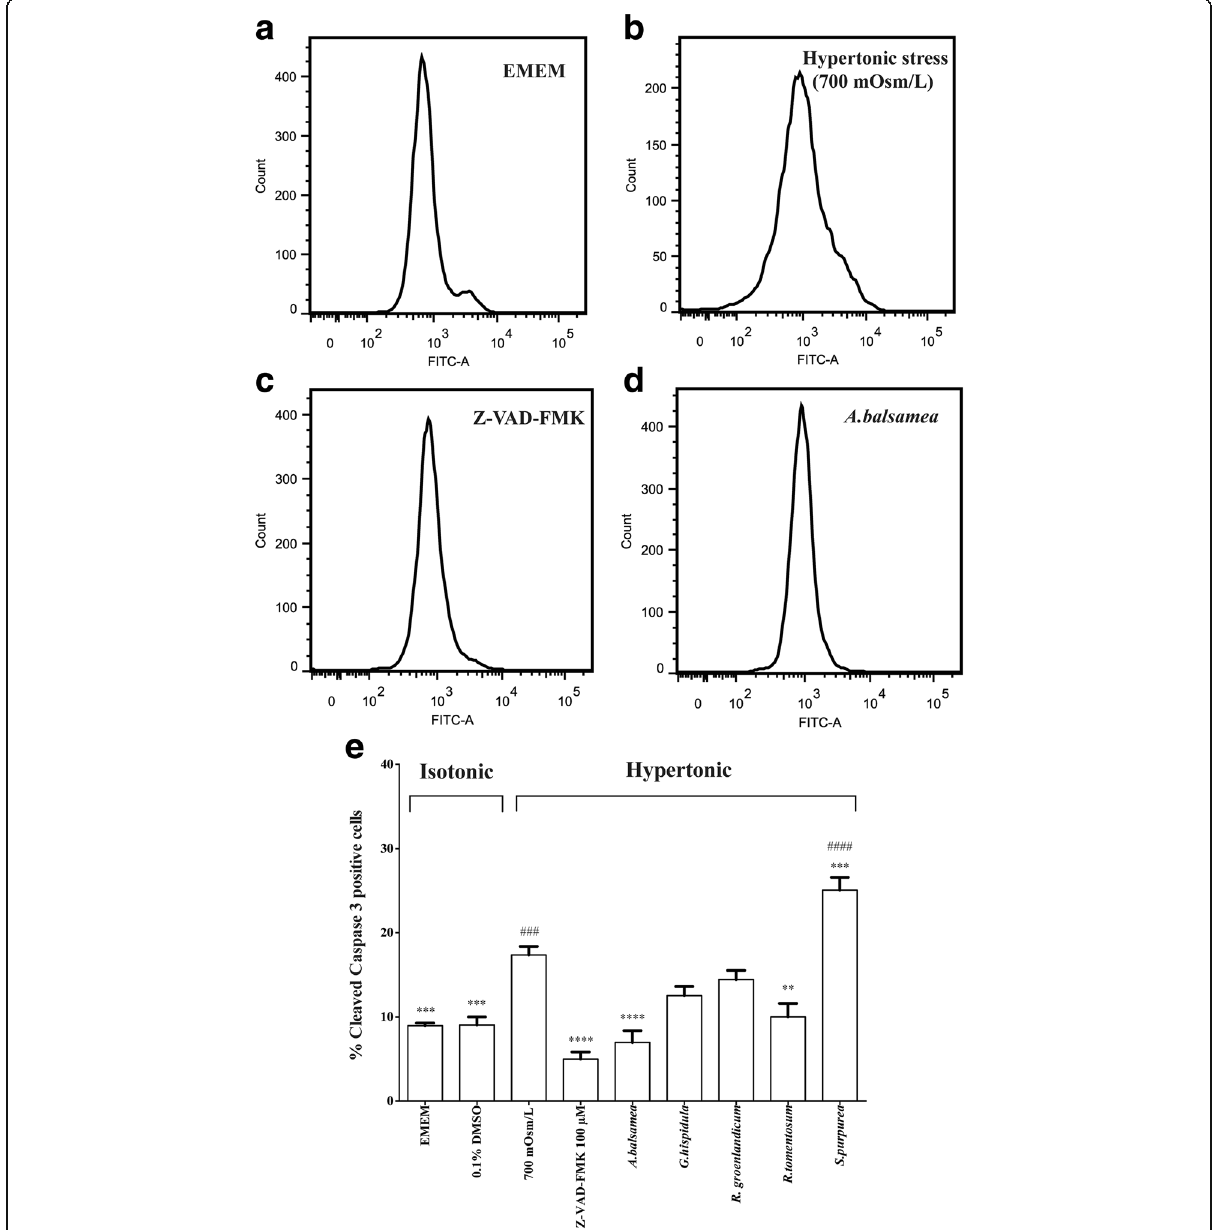
Fig. 2 Cleaved caspase 3 activity. Cleaved caspase 3 activity test was performed 18 h after the treatment with respective plant extracts. ( a - d ) Representative pictures of flow cytometry. Ordinate indicates cell count whereas abscissa represents fluorescence signal strength. From left to right, 1st peak indicates procaspase 3 and 2nd peak represents cleaved caspase 3 activity. e Histogram of percent cleaved caspase 3 positive cells. The percent cleaved caspase 3 activity was calculated as the area of 2nd peak/total area × 100. Results were expressed as means ± SEM for 3 separate experiments. * ( P < 0.05), **( P < 0.01), *** ( P < 0.001) and **** ( P < 0.0001) denotes other treatments significantly different from 700 mOsm/L hypertonic stress treatment, one-way ANOVA and Bonferroni test. ## ( P < 0.01), ### ( P < 0.001) and #### ( P < 0.0001) denotes treatment groups significantly different from isotonic EMEM, one-way ANOVA and Bonferroni